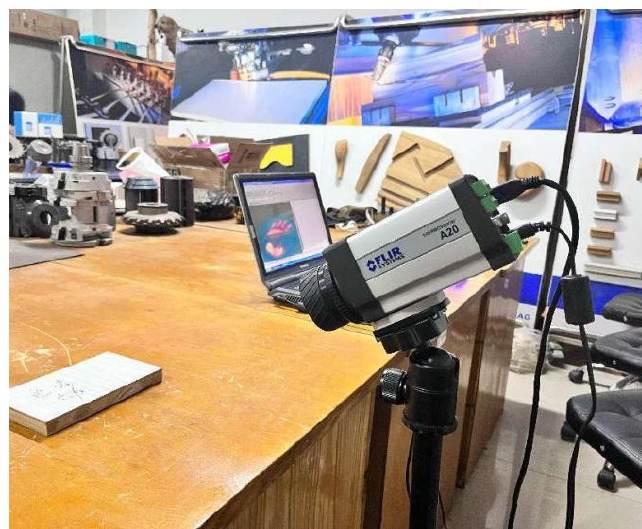
Figure 3. Material surface cooling rate test.